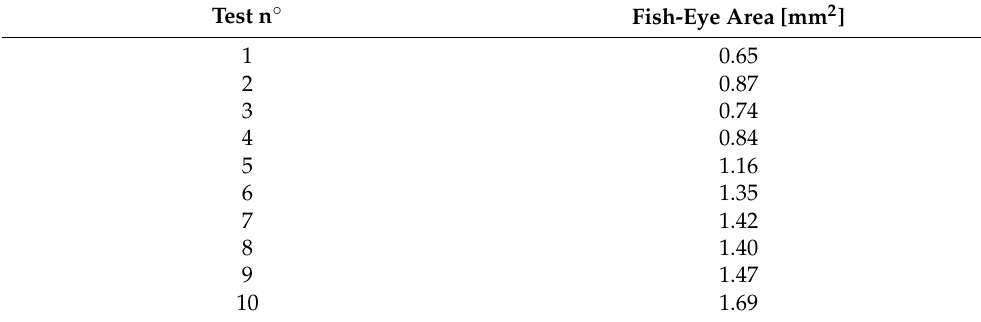
Table 11. Fish-eye area evaluation.